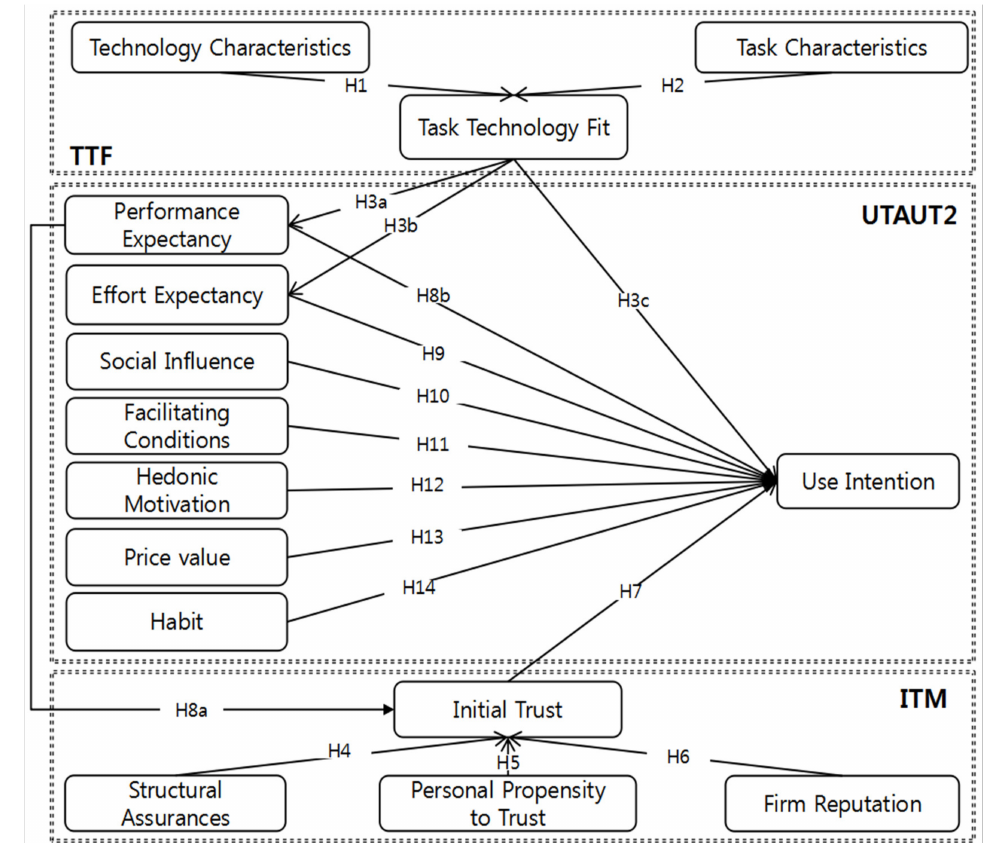
Figure 1. Research